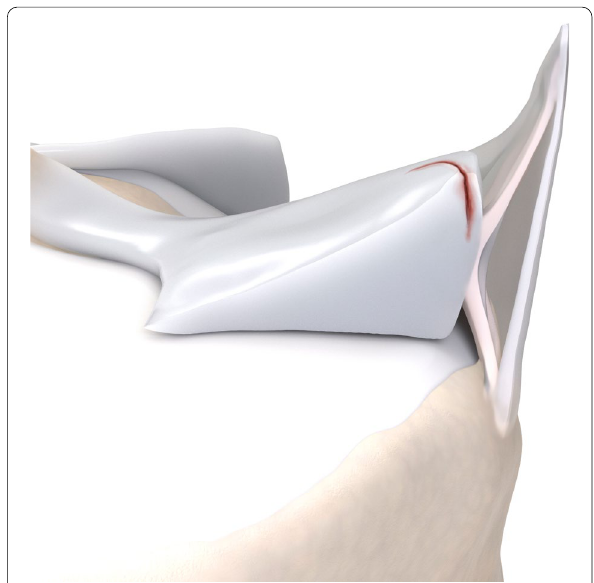
Fig. 4 Type 2 meniscal ramp lesion illustration, defined as partial superior peripheral posterior meniscal horn tear